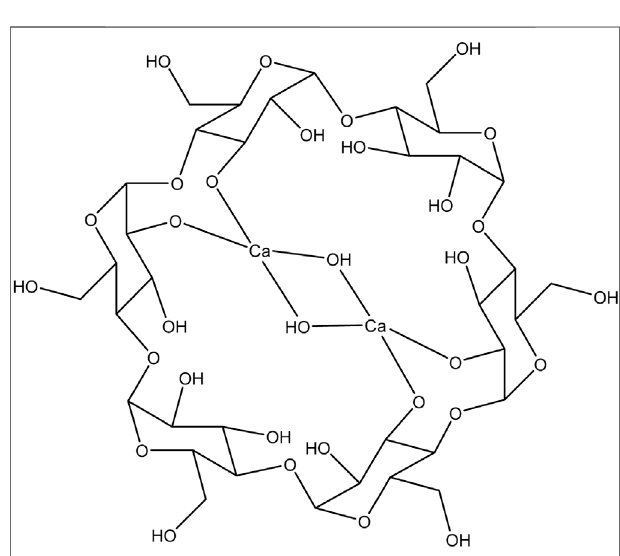
FIGURE 3 | Schematic representation for the fabrication of nano fi bers based on cyclodextrin.